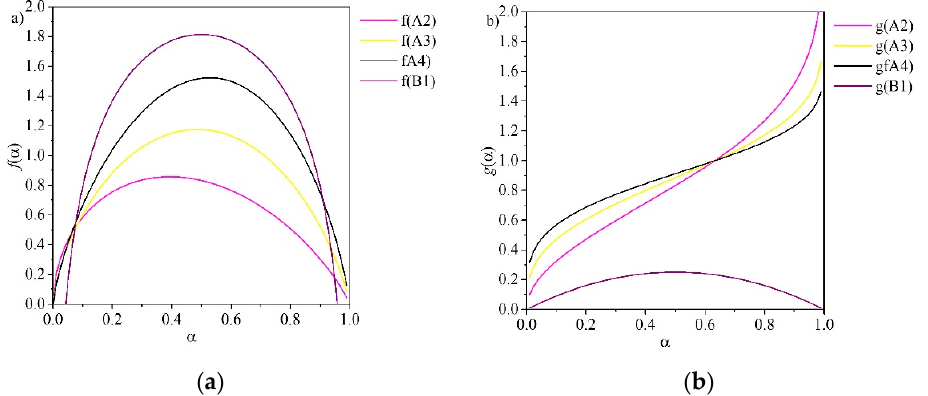
Figure 4. Nucleation-based reaction models: ( a ) f ( α )plots; ( b ) g ( α ) plots.